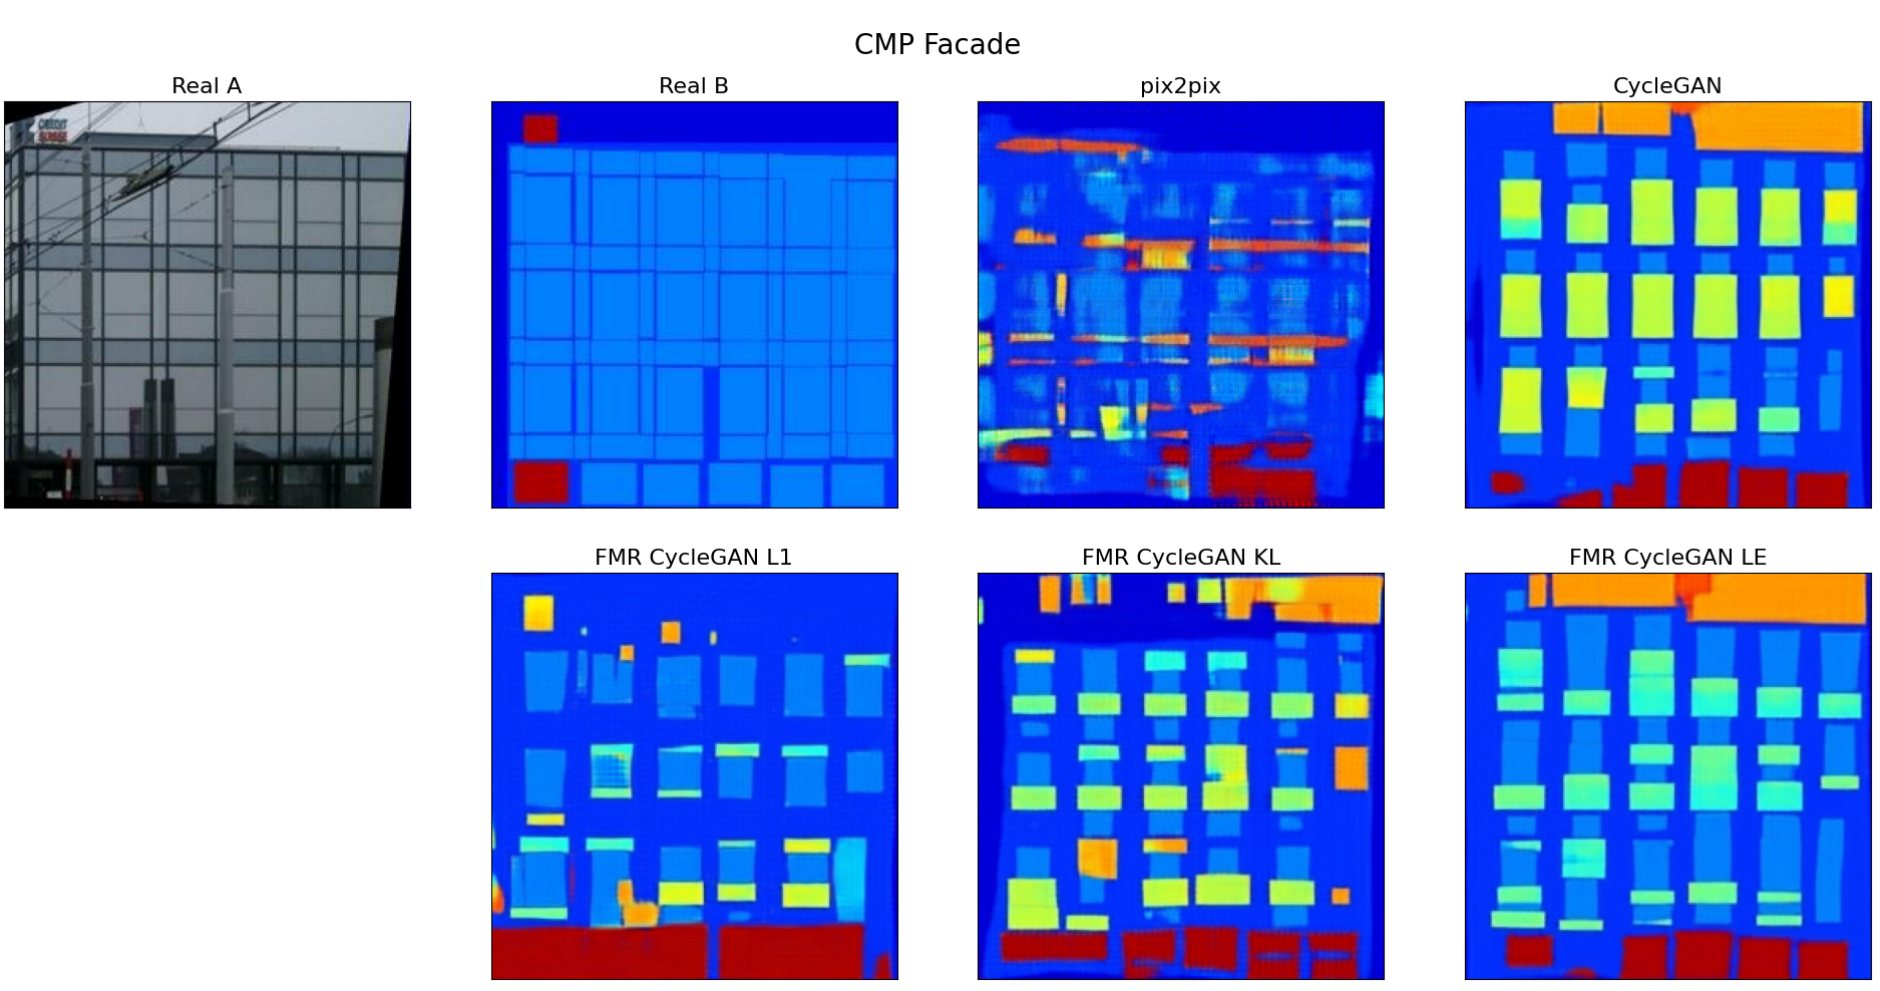
Figure 5. Visual comparison on the second example of paired images from the CMP Facade photo2labels task (denoted as “Real A”, belonging to the source or “left” domain, and “Real B”, belonging to the target or “right” domain). The Proposed FMR CycleGAN with various ground distances (L1 corresponding to (8), KL corresponding to (10), and LE corresponding to (12)) was compared against the baseline CycleGAN and pix2pix